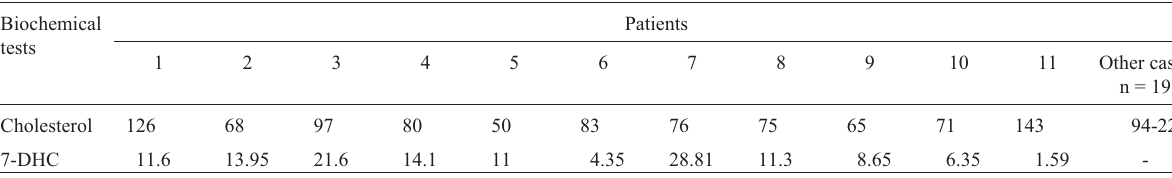
Table 3 - 7-DHC and cholesterol plasma levels (mg/dL) in patients suspected of having SLOS (n = 30). Biochemical tests